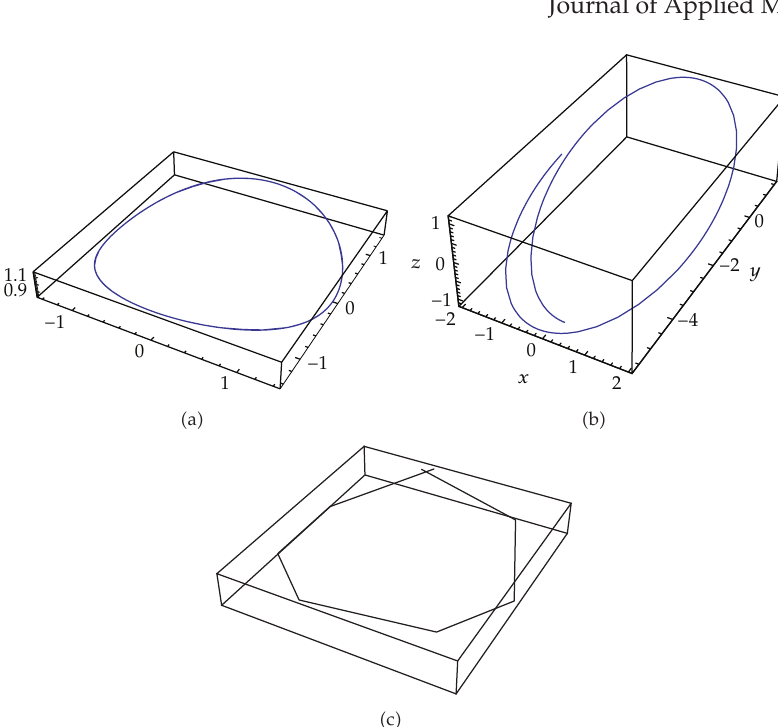
Figure 2: Runge-Kutta 4 steps, Lie-Trotter, and Kahan integrator, respectively (cid:2) x (cid:2) 0 (cid:5) (cid:7) y (cid:2) 0 (cid:5) (cid:7) z (cid:2) 0 (cid:5) (cid:7) 1 (cid:5)